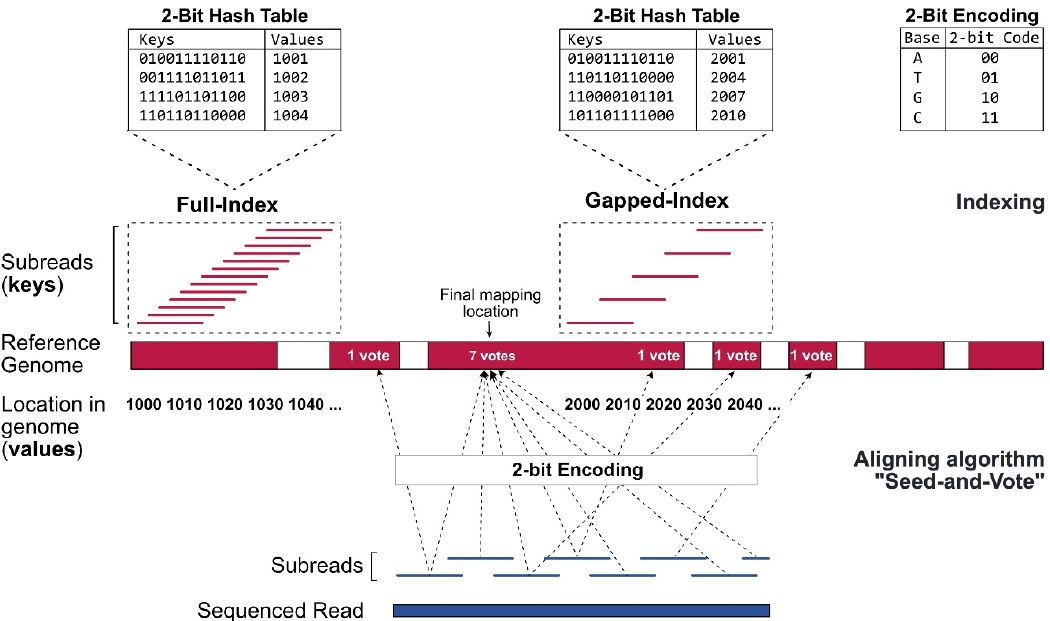
Figure 2. Indexing and alignment strategy of Rsubread for long RNA reads. The alignment strategy is based on short overlapping subreads, extracted from the sequenced reads (blue) and from the reference FASTA file (red). When determining the optimal mapping location of a long read, the seed-and-vote strategy allows the subreads (seeds) to vote for several positions (dashed arrows). The position with the highest number of votes is chosen as the final mapping location.